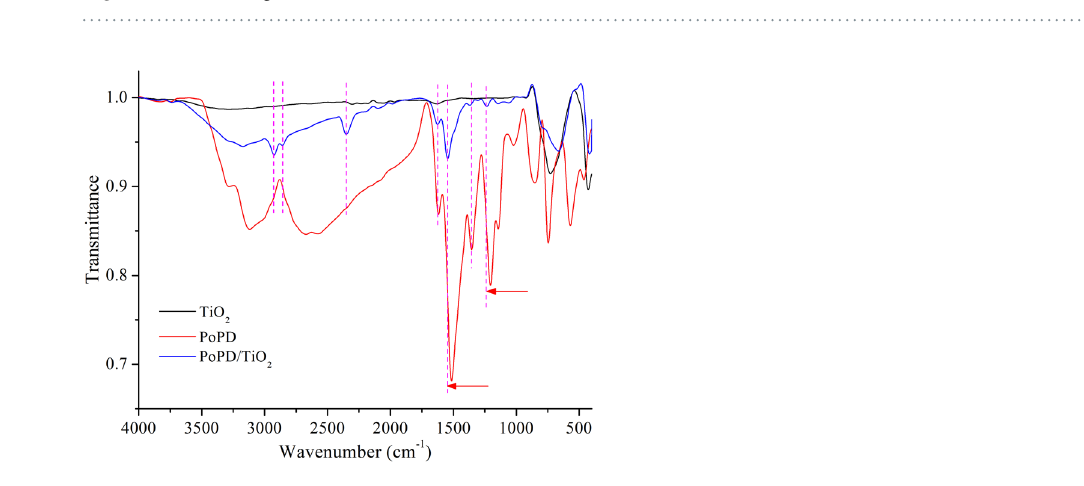
Figure 3. TEM images of ( a ) TiO 2 and ( b ) P/T(1/4).